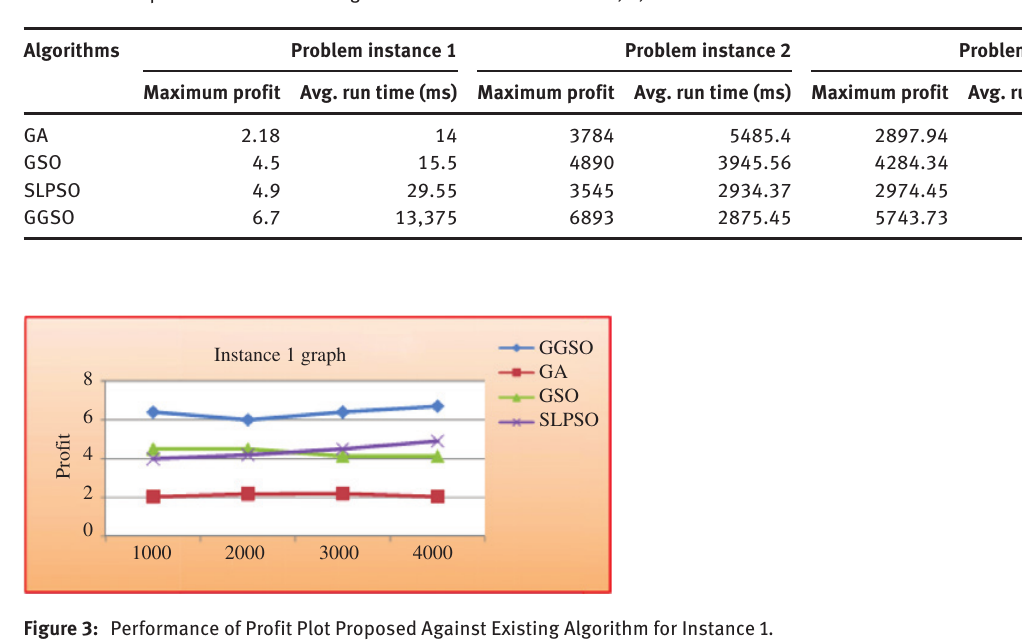
Table 13: Comparison of Profit and Avg. Time for Problem Instances 1, 2, and 3.